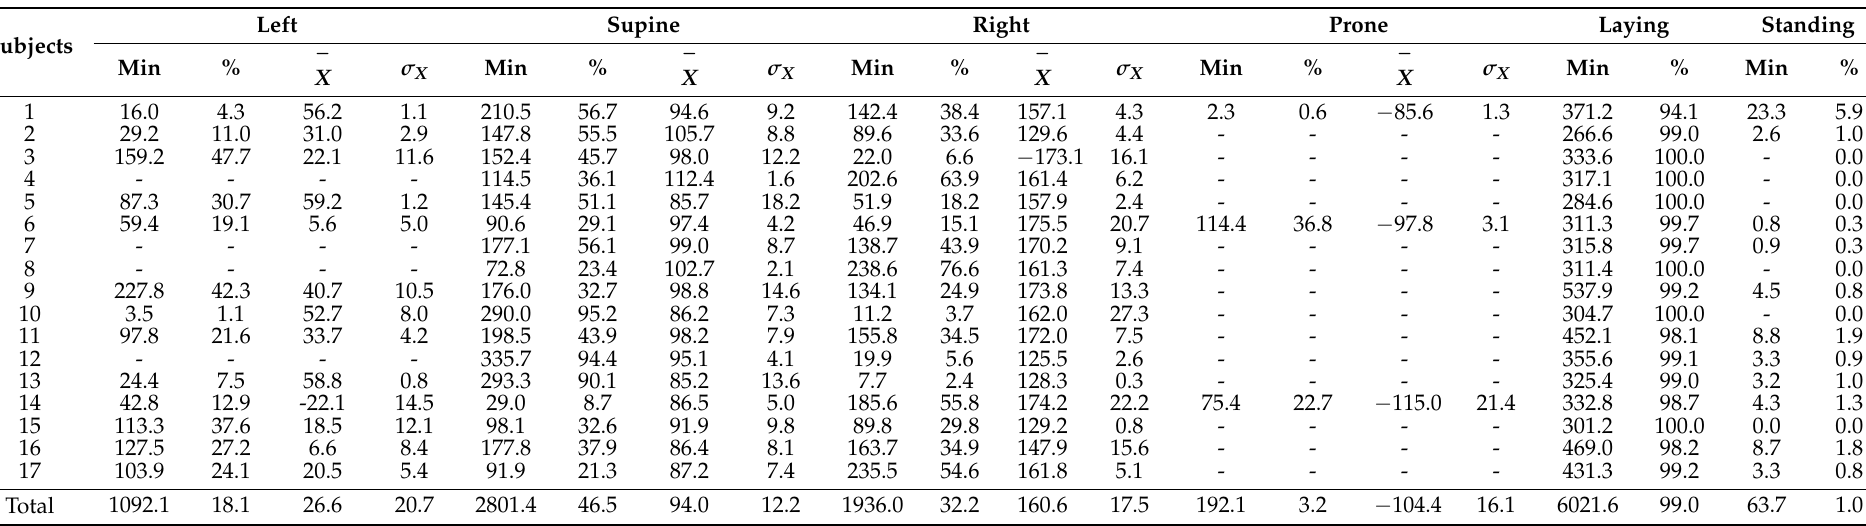
Table 1. Time spent in minutes (Min) and percentage (%), and sleep angle’s mean value ( X ) and standard deviation ( σ X ) for each sleep position and each patient. The time spent in minutes and percentage is also provided for the laying and standing